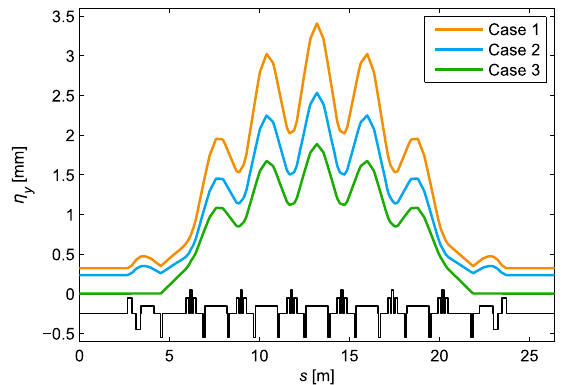
FIG. 2. Ideal vertical dispersion in Cases 1 to 3. Approximately 6.6 pm rad of vertical emittance is created in the ideal lattice which gives on average 7.9 pm rad when including imperfections.